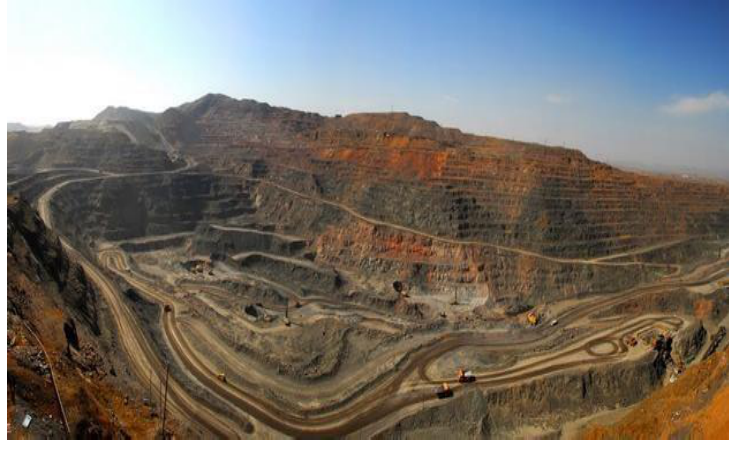
Figure 11. Iron mine.